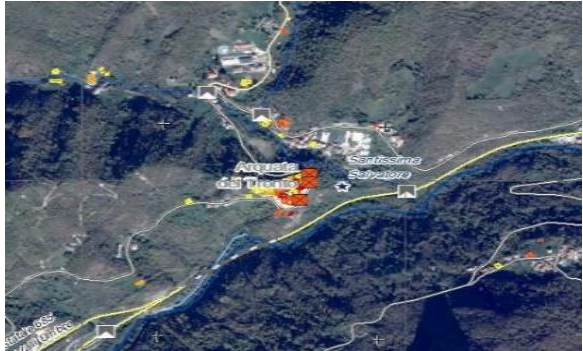
Figure 1. Grading map Arquate del Tronto after earthquake dated